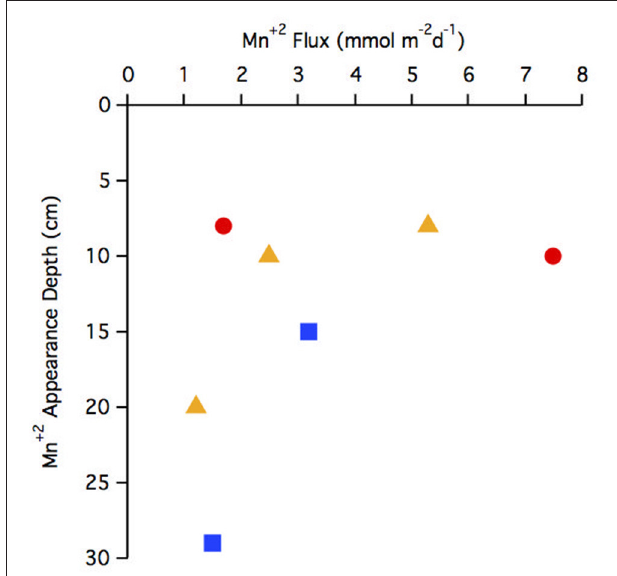
FIGURE 5 | Comparison of Mn + 2 appearance depth to flux. Geographic zonations are indicated with different symbols: central (red circle), north (blue square), east (yellow